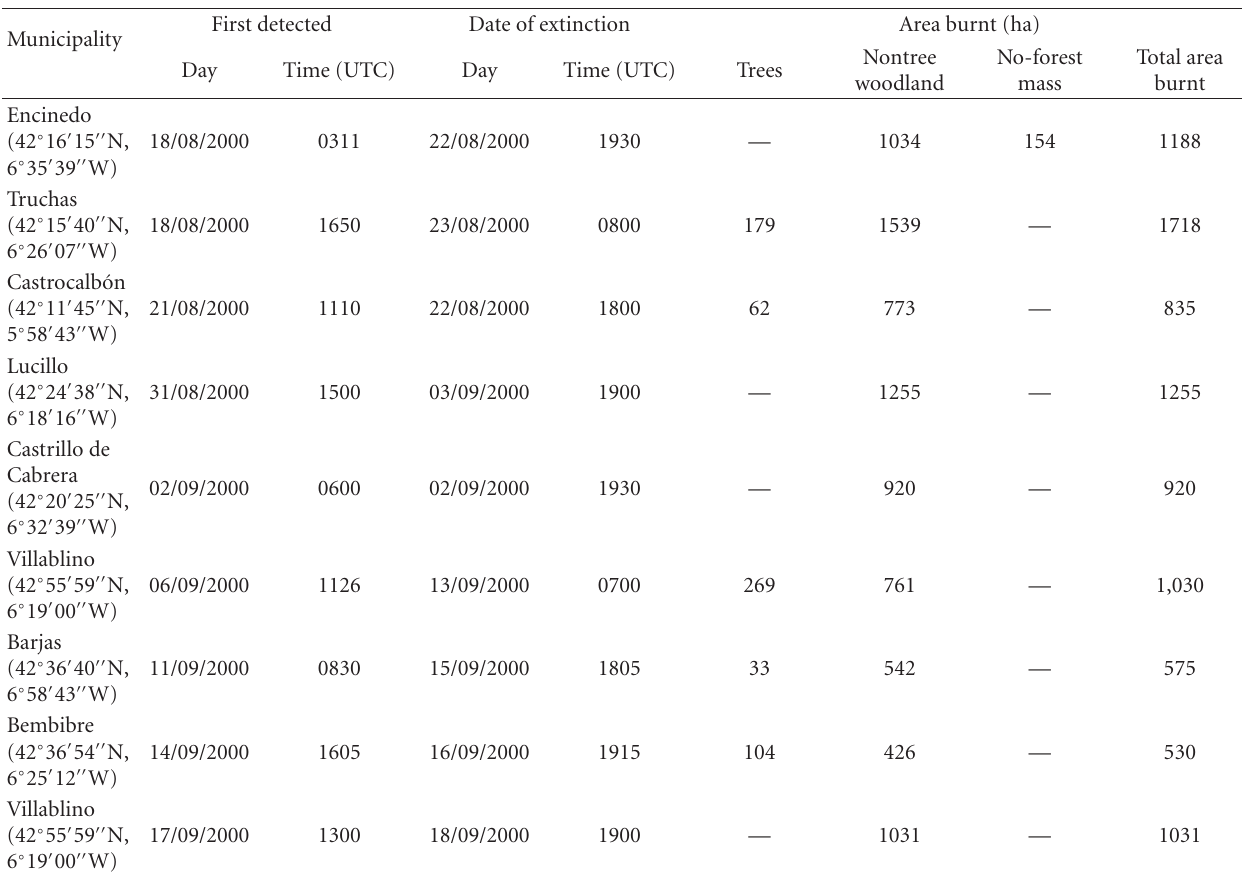
Table 4: District where the fire occurred, date of detection and extinction, land area burnt of each type of vegetation (trees, non-tree woodland, and no-forest land) and total land area a ff ected by the large fires (over 500 ha) in the summer of